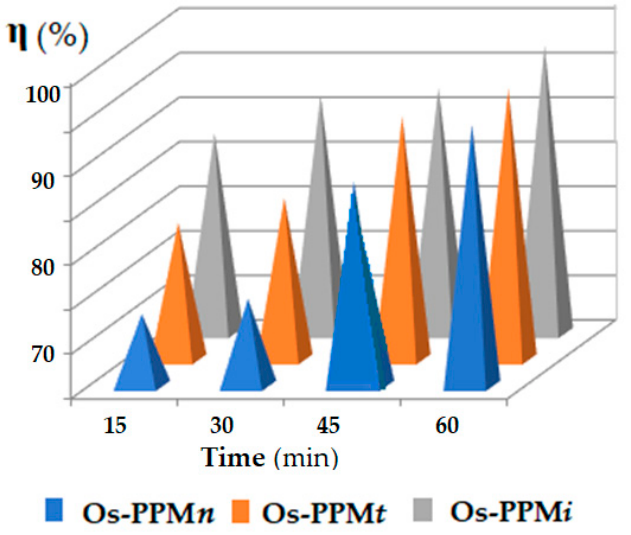
Figure 14. Evolution of p –aminophenol recovery efficiency in the case of osmium nanoparticles– alcohol–polymer composite membranes (Os–PPM).